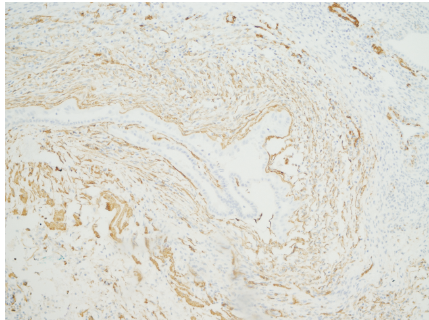
Figure 4: The spindle cell stroma diffusely positive for smooth muscle actin. Immunoperoxidase stain for smooth muscle actin; original magnification: